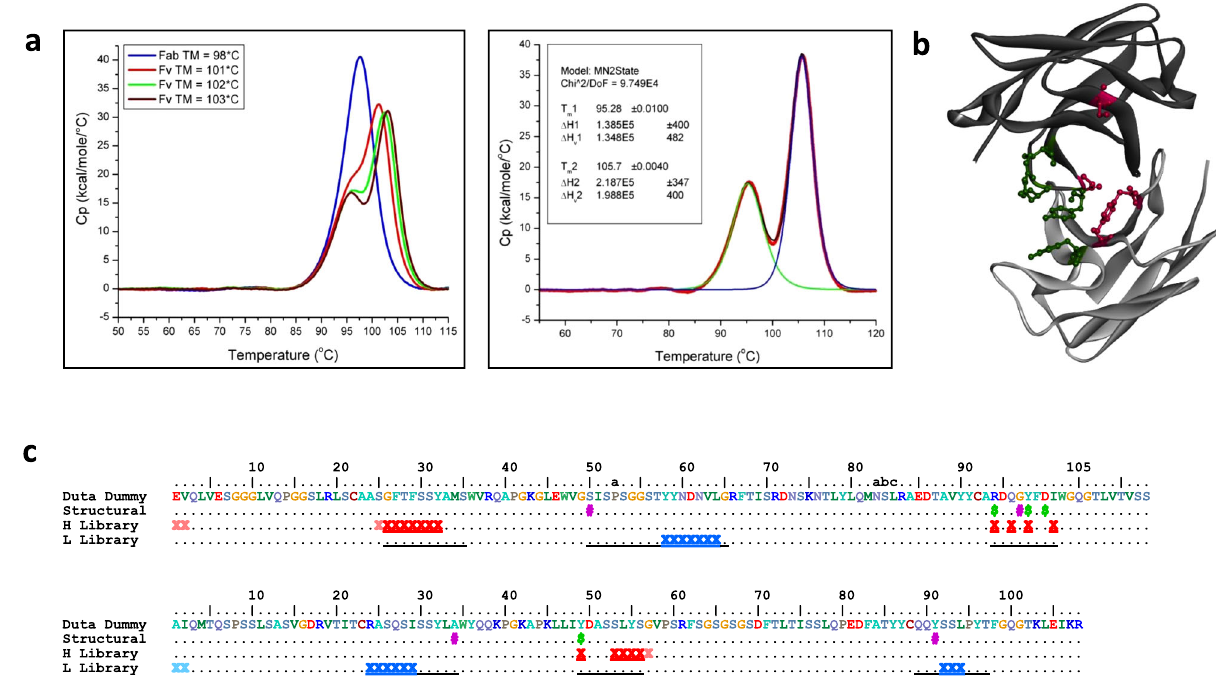
Fig. 2 DutaFab libraries. a DSC data of different human VH3-Vk1 DutaFab dummy scaffolds. Left side: Up to a Fab thermostability of 99 °C, co-operative melting of all 4 domains in the Fab is observed (blue trace). Above 99 °C, a left shoulder starts to appear, representing the unfolding of CH1-Ck constant domains in the presence of folded Fv (red, green and brown traces of Fab unfolding data). Right side: In case of high Fv stabilities, constant domain unfolding can be analyzed independently; the red trace represents the data for a Fab fragment with an Fv TM of 105.7 °C, the green trace the non-2-state fi t for the earlier melting constant domain unfolding event and the blue trace the non-2-state fi t for the later melting Fv unfolding event ( fi tted with Origin software). b Top-down view on a DutaFab scaffold showing conserved structural residues that maintain stability or conformation. DutaFab heavy and light chains are colored dark and light gray, respectively. Residues conferring high stability or restricting HCDR3 conformation are colored according to panel c . The structure is based on PDB 6T9D, which is discussed in further detail below. c Typical DutaFab library design, showing H-side diversi fi ed residues (dark red X), optionally diversi fi ed H-side enhancing residues (light red X), L-side diversi fi ed residues (dark blue X), optionally diversi fi ed L-side enhancing residues (light blue X), stability residues (pink #) and HCDR3 conformational residues (green $). Underlined: all positions designated as CDRs in either the Kabat, Chothia, and Contact de fi nitions 43 – 45